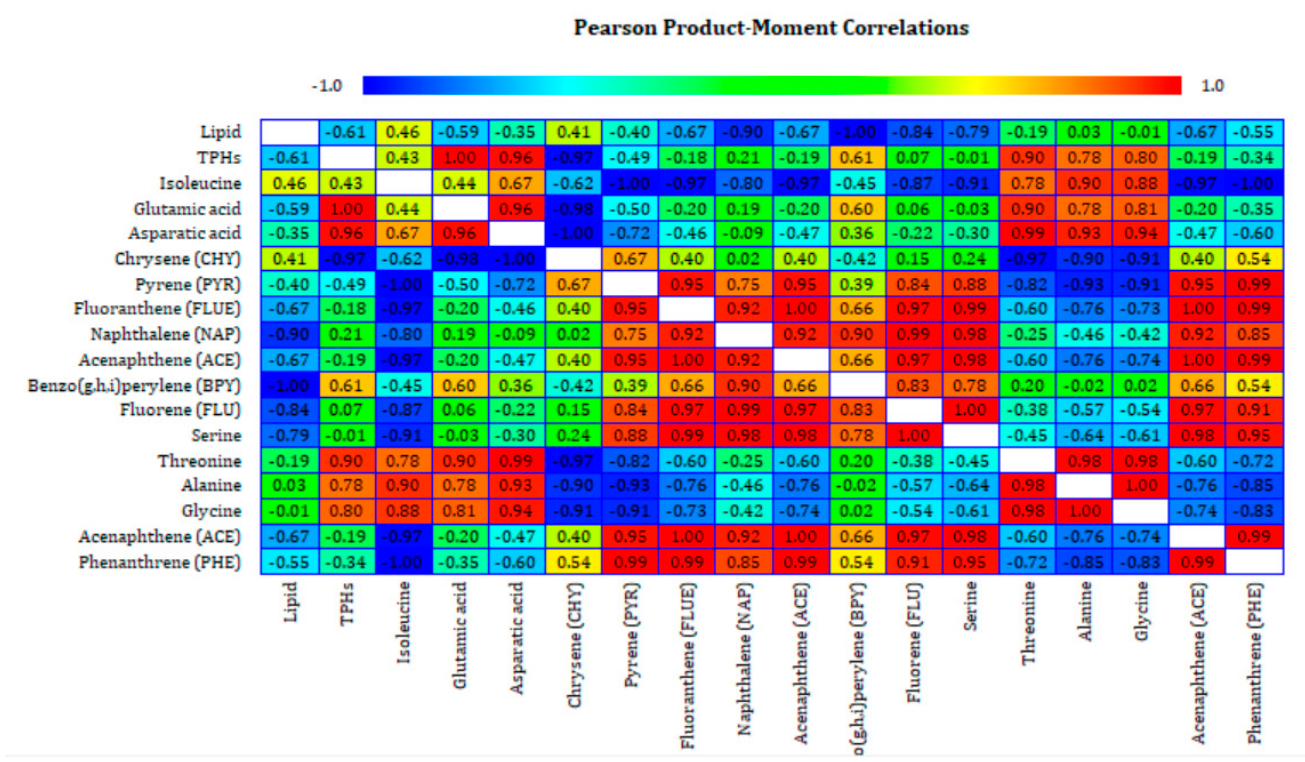
Figure 5. Pearson product-moment correlation coefficients between the different variables.